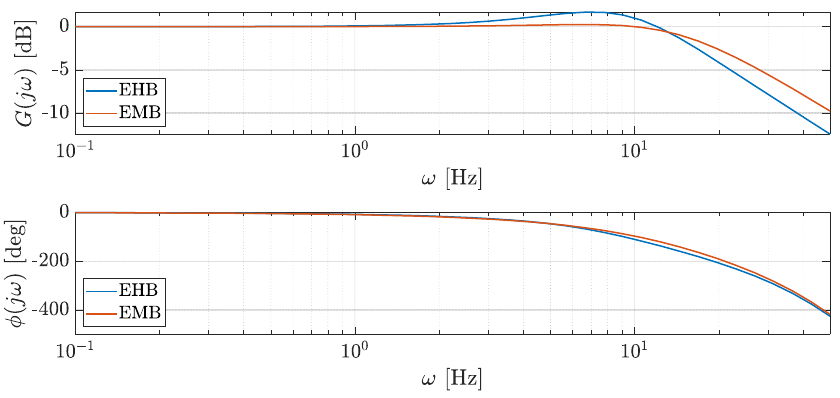
Figure 2. Bode diagram for torque request with sine-sweep profile.